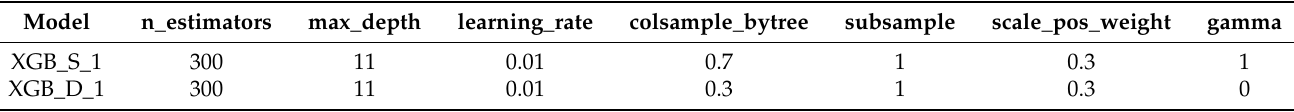
on Figure 5 Table 12. Values of the tested hyperparameters of the best